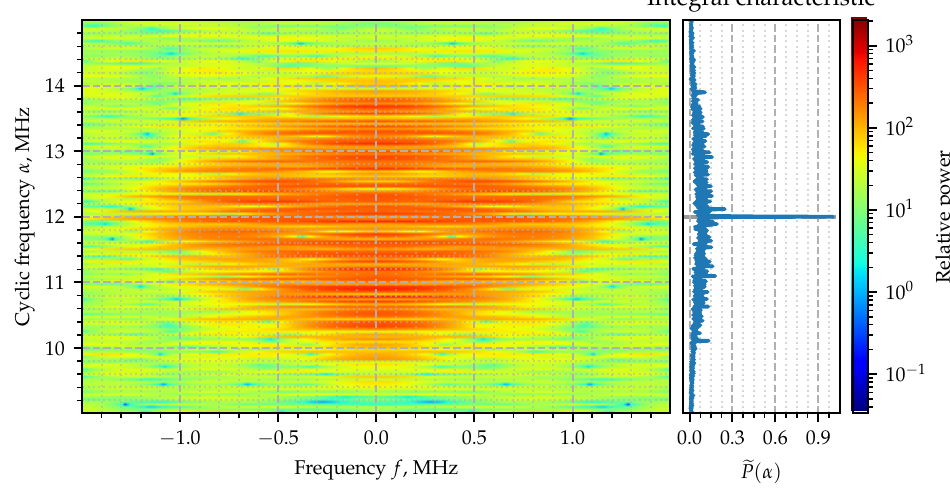
Figure 6. Estimated spectral correlation density of the AM signal.